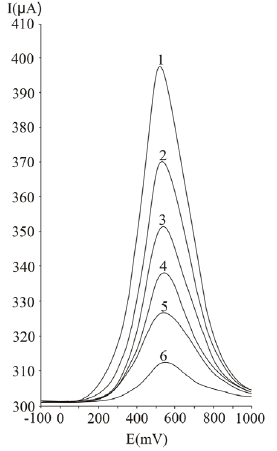
Figure 4. Influence of the pulse period on the analytical signal at ascorbic acid determination by differential pulse voltammetry, at a Pt working electrode; 50 ms (1), 75 ms (2), 100 ms (3), 125 ms (4), 150 ms (5); experimental conditions: pulse amplitude 75 mV, potential scan rate 50